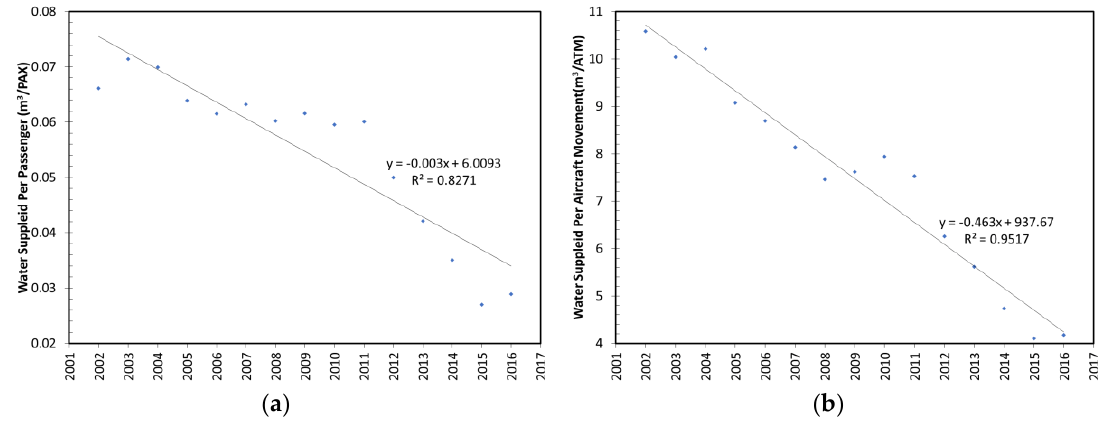
Figure 6. The scatter plot showing the line of best fit and correlation coefficient (squared) of KIX 2002–2016 annual municipally supplied water consumption: ( a ) per passenger and ( b ) per aircraft movement. Source: Data derived from References [10–13].